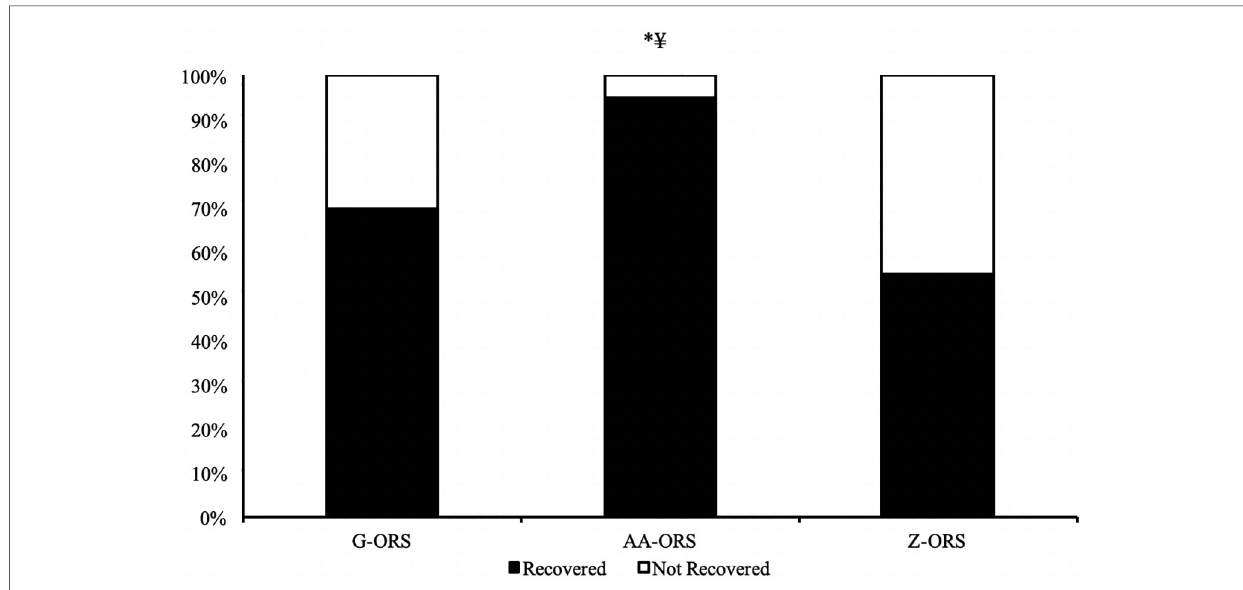
FIGURE 5 Percentage of participants fully reaching full restoration of fl uid balance. *, AA-ORS greater vs. Z-ORS (P <0.05); ¥, AA-ORS greater vs. G-ORS (P